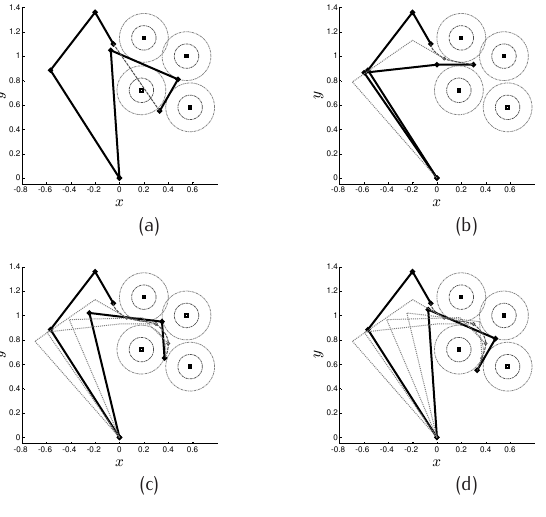
. (Figure 9(c)). max = 0